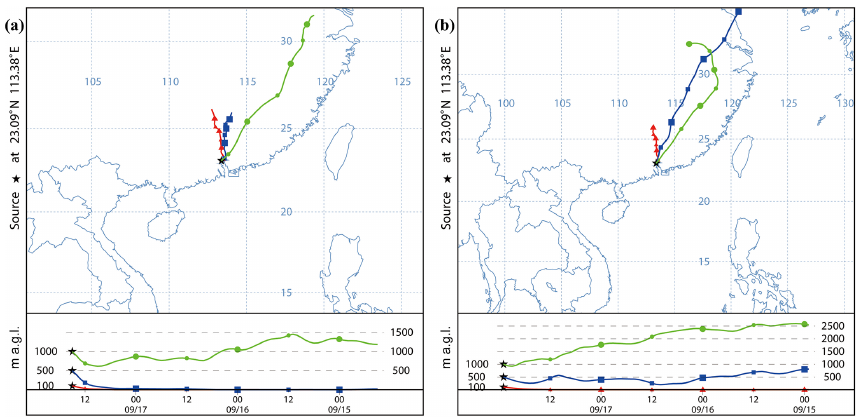
Figure 10. Backward trajectories at 100, 500, and 1000m, ending at 23:00LT on 17 September 2019 (a) and 07:00LT on 18 Septem- ber 2019 (b) , determined by the HYSPLIT